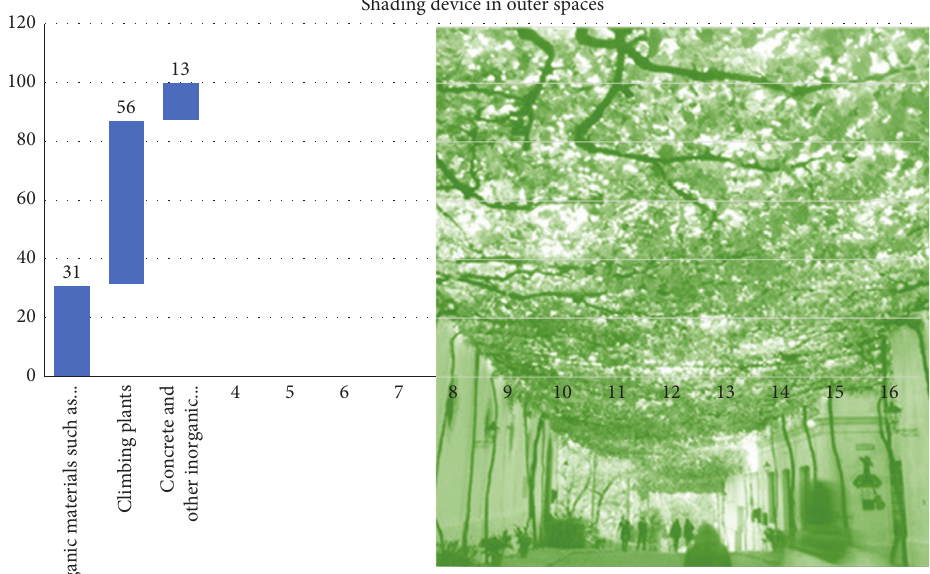
Figure 8: Shading device for outer